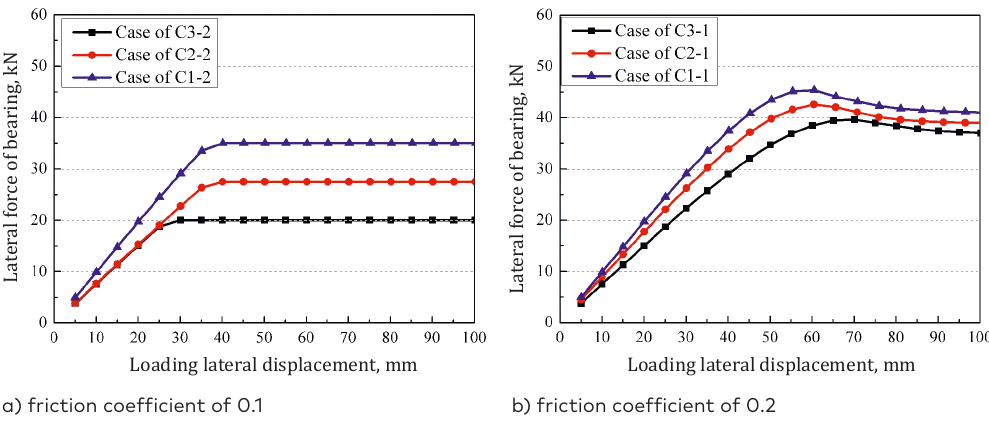
a) friction coefficient of 0.1 Figure 9. Comparisons of horizontal force-displacement curves under asymmetry connection at both ends of the bearing